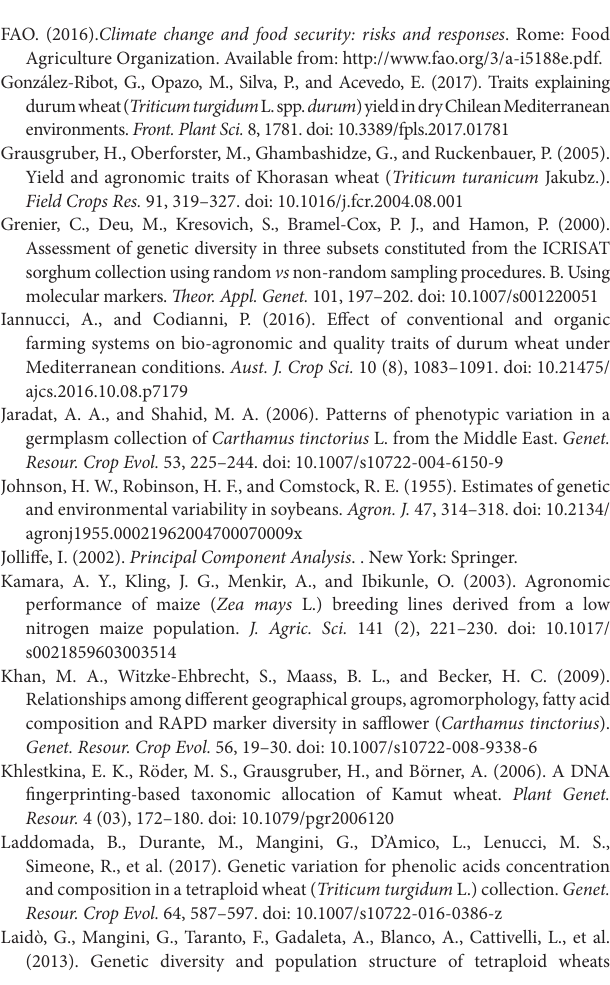
FiGUre S1 | Heat map for Pearson ’ s correlation coefficients between the quantitative traits measured for the 77 Khorasan wheat accessions. Correlation coefficients were classified as weak (NS), moderate (P ≥0.05) and strong (P ≥0.01)